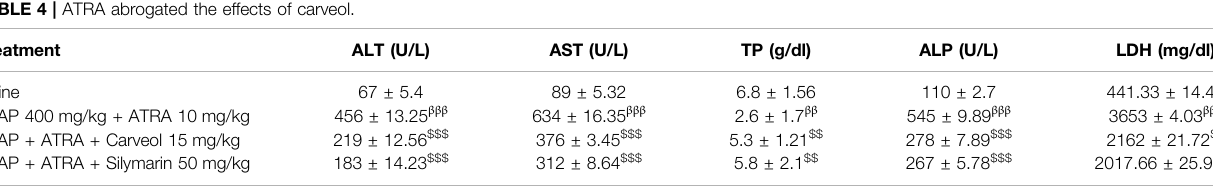
TABLE 4 | ATRA abrogated the effects of